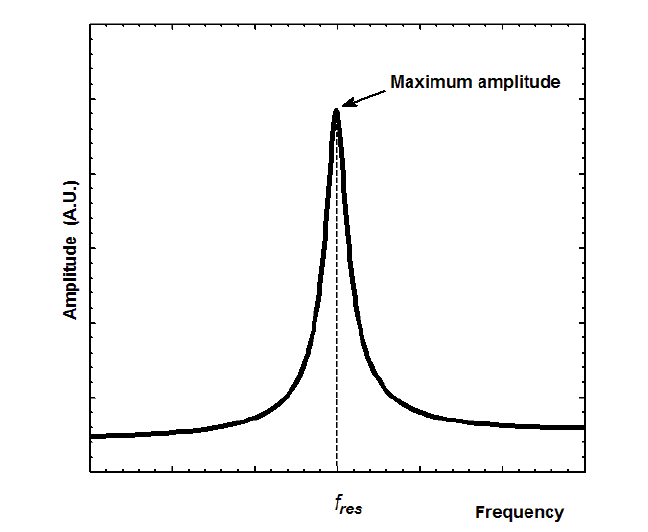
Figure 3. Typical amplitude (arbitrary units) response of a resonant structure with a high quality